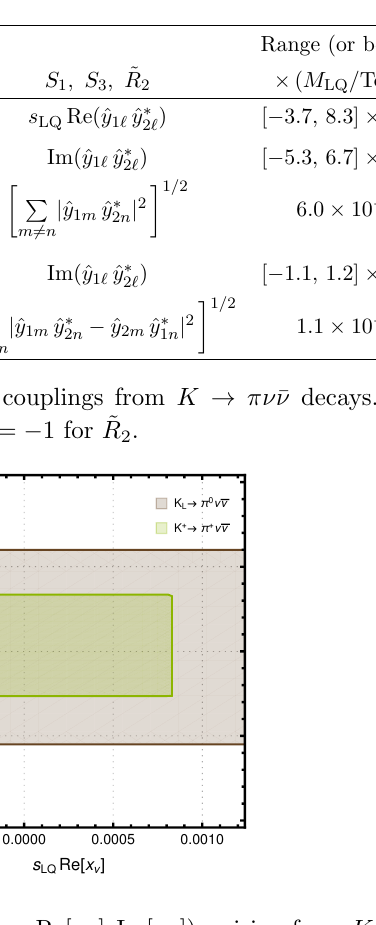
Figure 4 . Allowed regions in the plane ( s LQ Re[ x (cid:23) ] ; Im[ x (cid:23) ]), arising from K ! (cid:25)(cid:23) (cid:22) (cid:23)